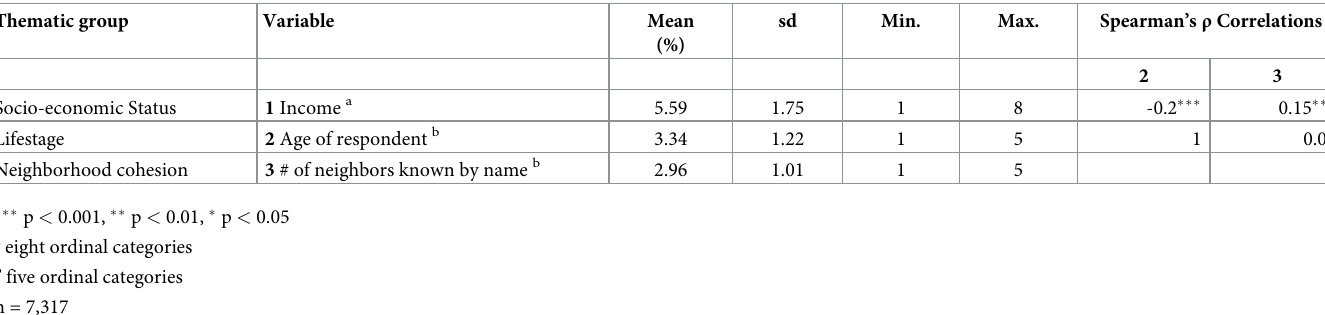
Table 1. Descriptive statistics of the independent variables: Income, age, and number of neighbors known by name in six metropolitan areas of the United States. Thematic